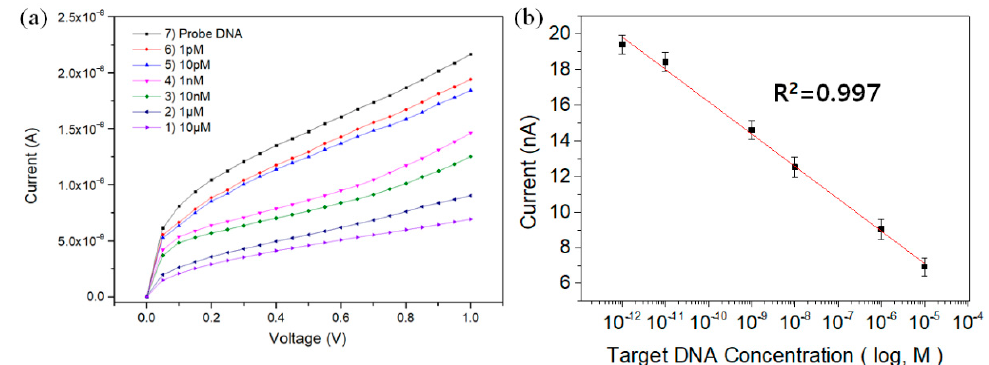
Figure 7. ( a ) Current responses of target DNA with varied concentrations and ( b ) calibration curve for current values at 1.0 V for varied concentrations of target DNA.